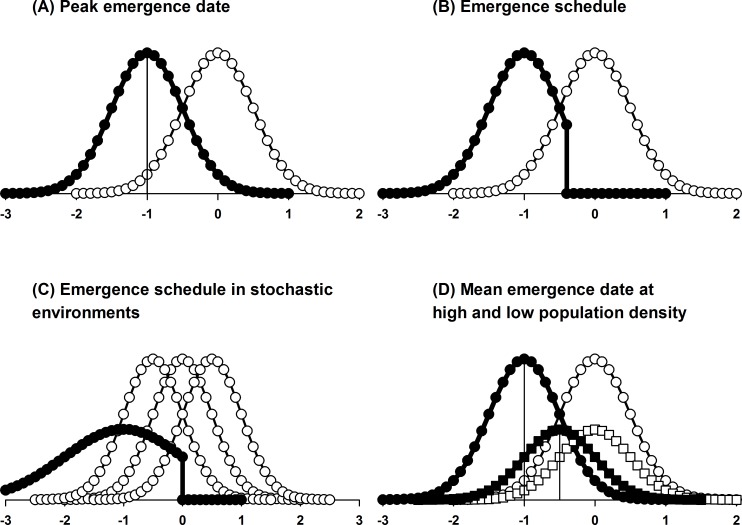
Comparison of the key features of different protandry models. In all cases, selection modifies male emergence date (filled symbols) in response to the female emergence curve (open symbols).Abscissa, emergence date (arbitrary units); ordinate, number emerging. (A) Protandry results from selection on peak male emergence date (vertical line); (B) frequency-dependent selection modifies the shape, as well as the mean, of the male emergence curve, which is predicted to be truncated; (C) a bet-hedging strategy increases the variance of the male emergence curve in response to stochasticity in female emergence date (here represented by varying position of female emergence curve); (D) mate encounter rate modifies degree of protandry, which is more pronounced in high (circles) than in low (squares) density populations (ordinate, number per unit area (density) emerging; this model reverts to the assumption that only the mean emergence date is modified by selection).